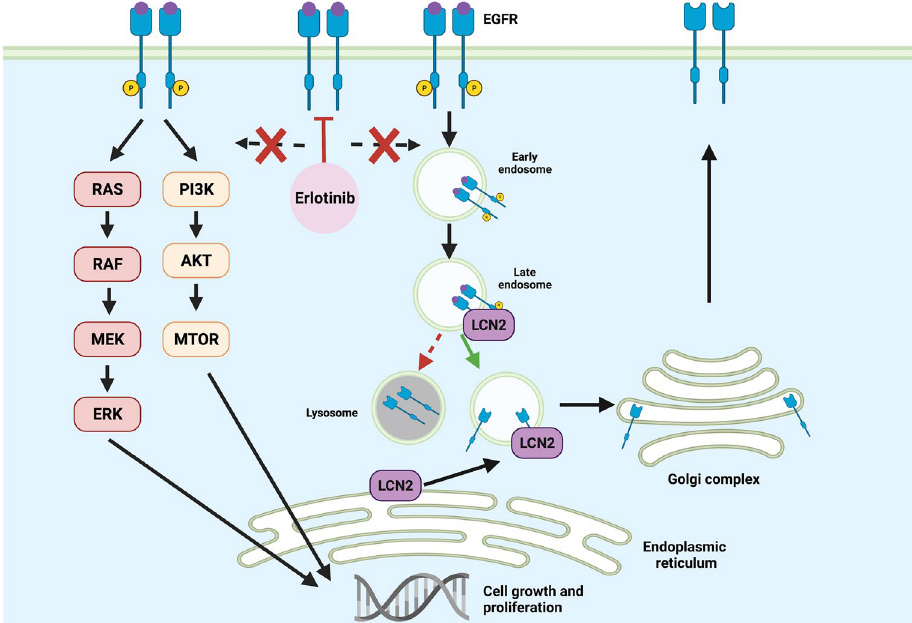
Figure 7. Hypothetical model depicting how LCN2 upregulation in erlotinib-resistant tumors may contribute to EGFR recycling back to the plasma membrane and allow for continued oncogenic EGFR pathway activity despite EGFR inhibition by erlotinib. Schematic of EGFR recycling via LCN2 was adapted from Yammine et al. 40 . Created with